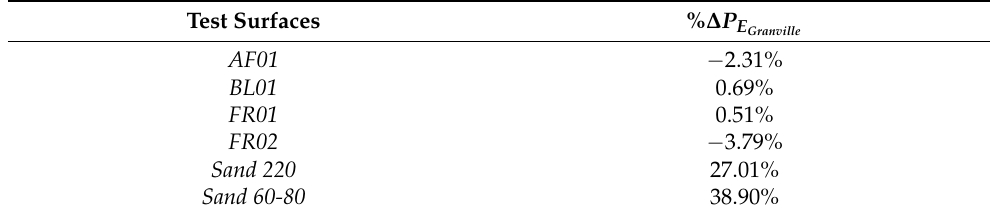
Table 10. Effective power variation ( % ∆ P E ) of the full-scale KCS at 24 knots ( Fn = 0.26 Figure 14. Frictional and total resistance coefficients variation in different hull roughness condi- tions.